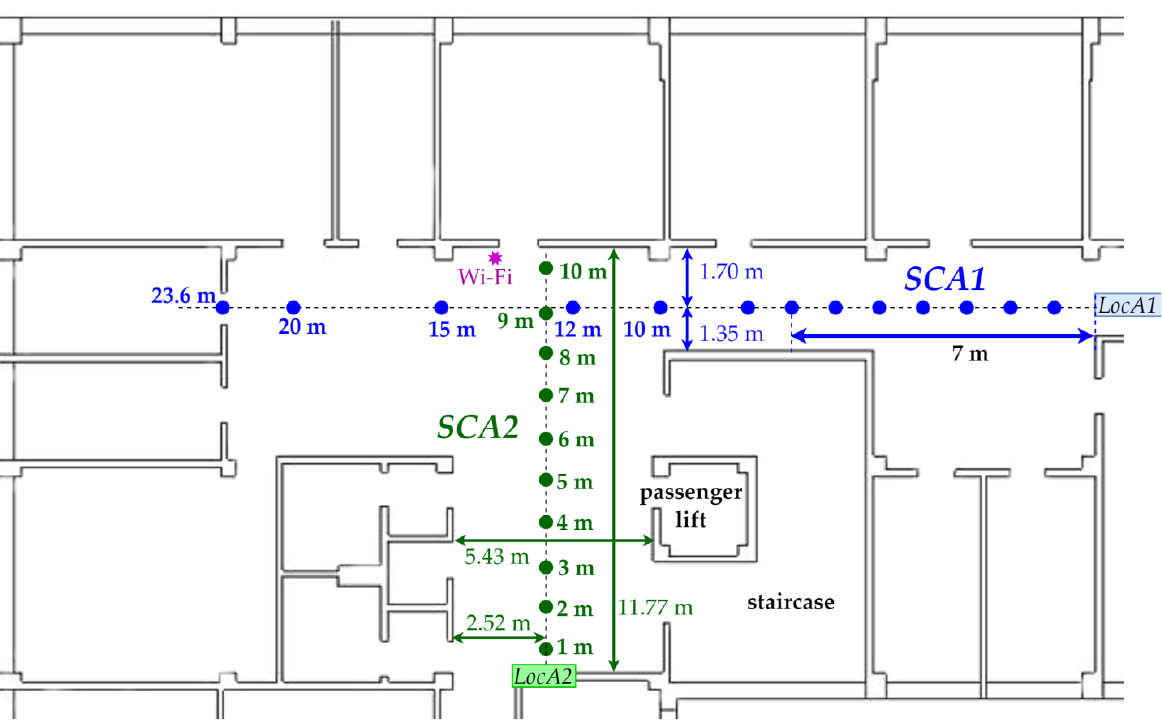
Figure 2. Situation sketch showing the performed series of measurements SCA1 (blue color) and SCA2 (green color) in Stage A studies.